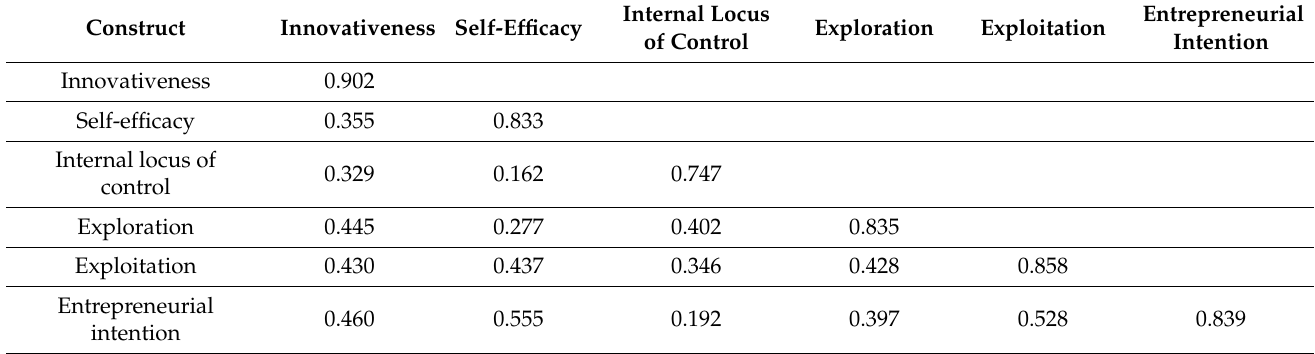
Table 6. Analysis of discriminant